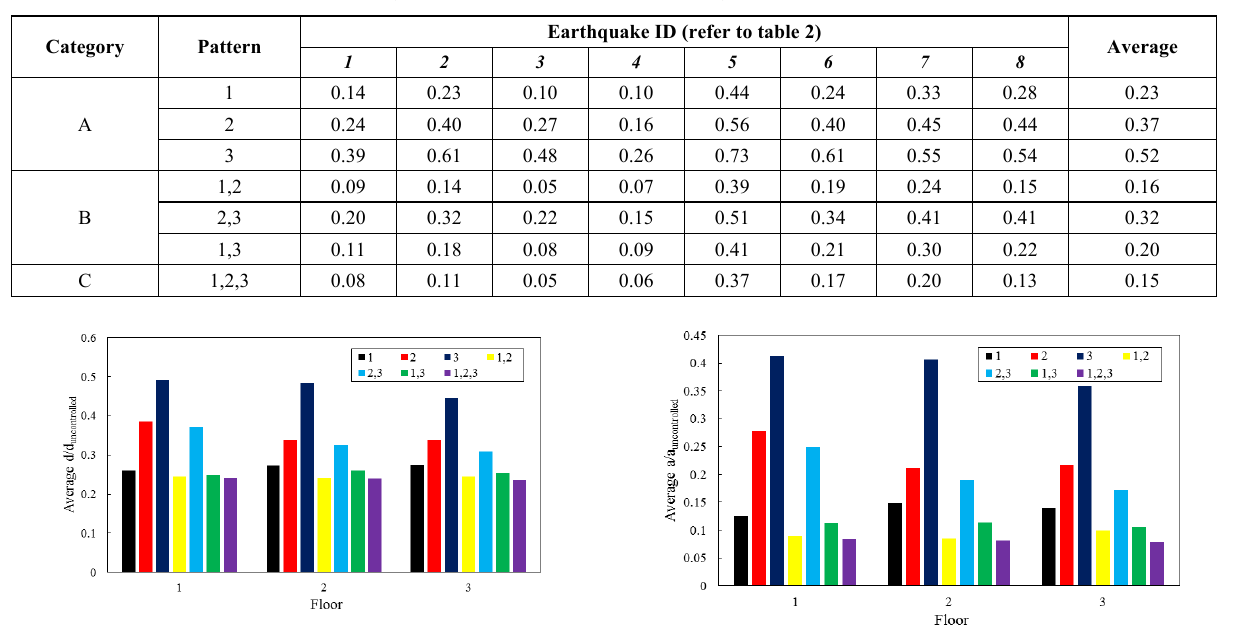
D ISPLACEMENT COMPARISONS ( RELATIVE TO UNCONTROLLED RESPONSE ) BETWEEN DIFFERENT PLACEMENT PATTERNS Category Pattern